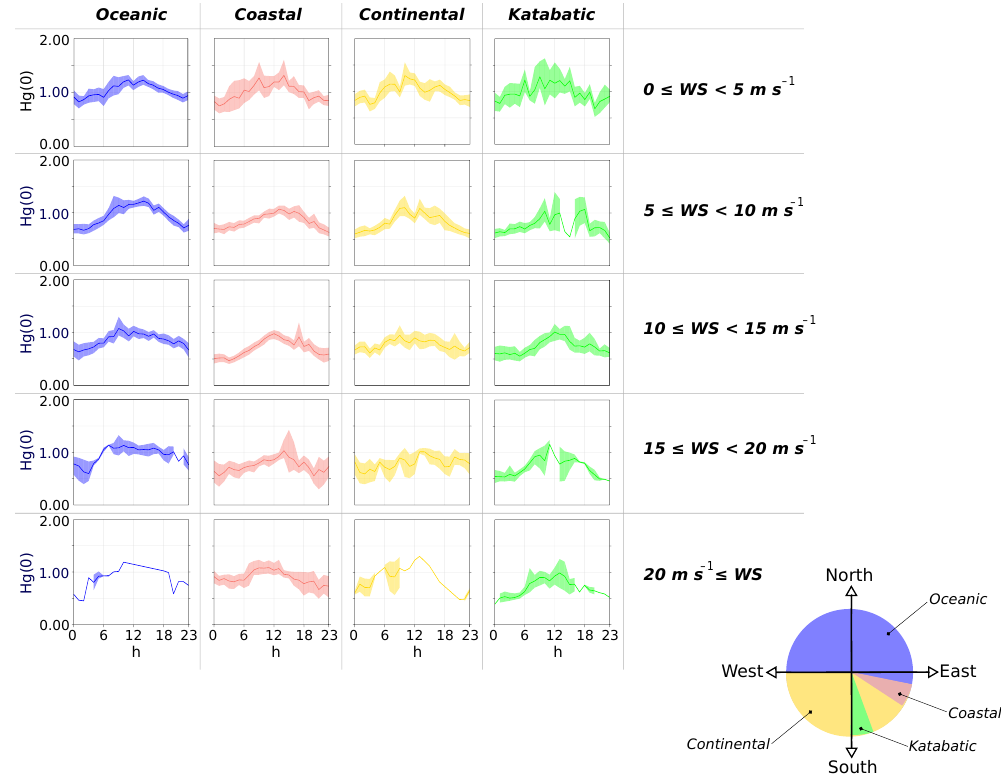
Figure 8. Summertime (November–February) mean diurnal cycle of Hg(0) concentrations (in ngm − 3 ), along with the 95% confidence interval for the mean, depending on wind direction and wind speed. With north at 0 ◦ , oceanic winds ranged from 270 to 110 ◦ , coastal winds from 110 to 130 ◦ , katabatic winds from 160 to 180 ◦ , and continental winds from 130 to 160 ◦ and from 180 to 270 ◦ . Hours are in local time (UTC + 10). Hg(0) concentrations exhibit a diurnal cycle regardless of wind speed and direction.